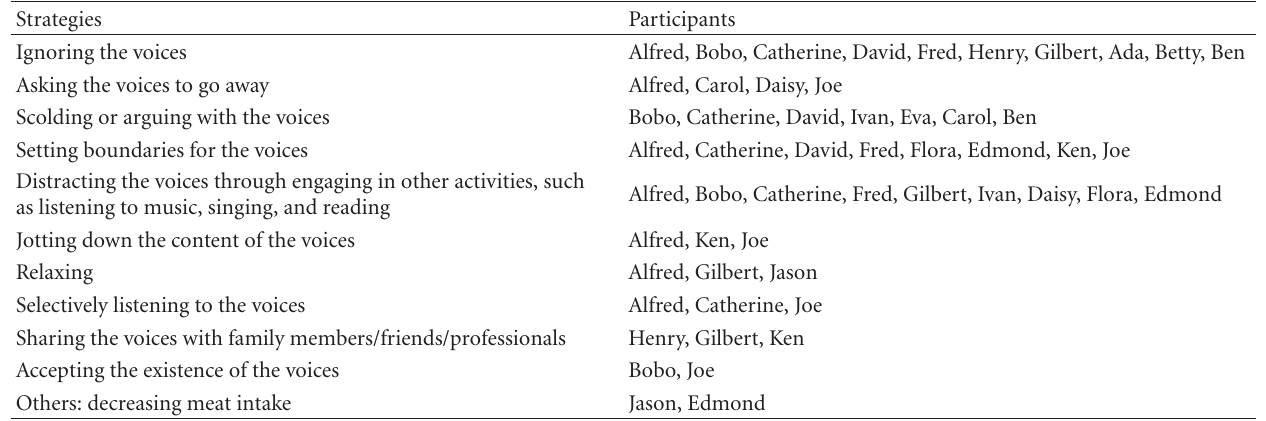
Table 2: Coping strategies adopted by the